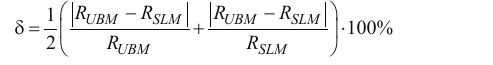
for the values of friction factor 0 ≤ m ≤ 1 and die channel intersection angle 2 θ =90° the maximum divergence of for total shear g by two-way calculations is results d max S d ( g )|( 2 θ =90° ) = 5.337% . max For the Segal die with 2 θ =105° and friction factor 0 ≤ m ≤ 1 the maximum difference d for total shear g by two-way max S ( g )|( 2 θ =105° ) = 3.662% . And for the Segal calculations is d max die with 2 θ =120° and friction factor 0 ≤ m ≤ 1 the maximum for total shear g by two-way calculations is difference d max S d ( g )|( 2 θ =120° ) = 5.323% . max